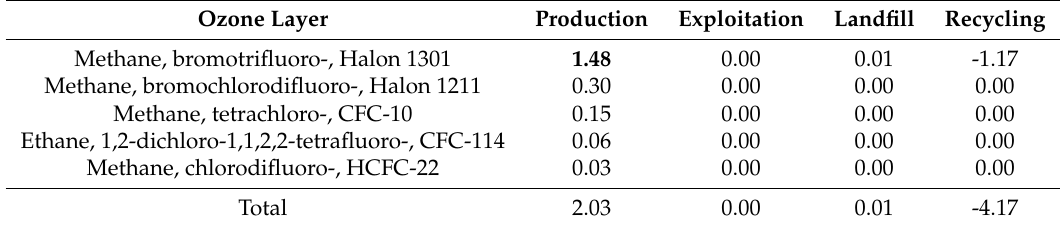
Table 9. Results of grouping and weighting of environmental after-e ff ects for ozone-increasing compounds, occurring in the 1 megawatt photovoltaic power plant [unit: Pt].